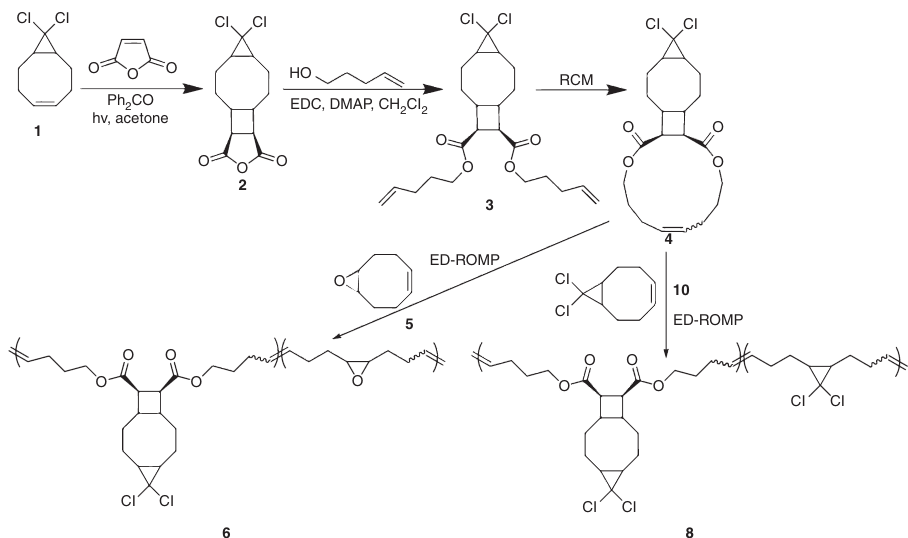
Figure 3 | Chemical structures and synthesis of polymers 6 and 8. Experimental details are provided in the Supplementary Methods; EDC and DMAP are N-(3-dimethylaminopropyl)-N 0 -ethylcarbodiimide hydrochloride and 4-dimethylaminopyridine, respectively. The ring closing metathesis and entropically- driven ring opening metathesis co-polymerization steps used Grubbs second generation catalysts.